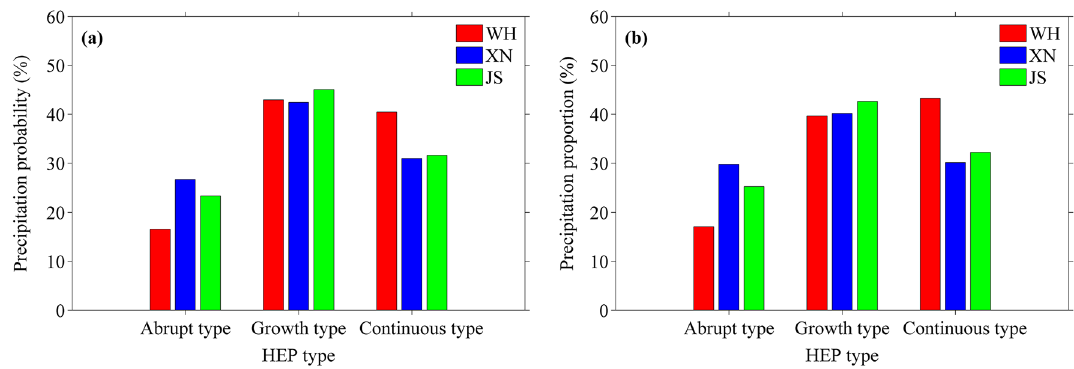
Figure 8. Precipitation ( a ) probability and ( b ) proportion of the three HEP types at WH, XN and JS stations during